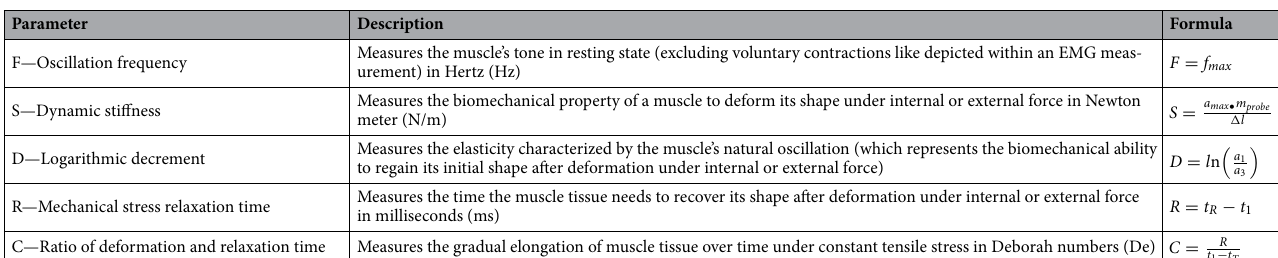
Table 2. MyotonPRO